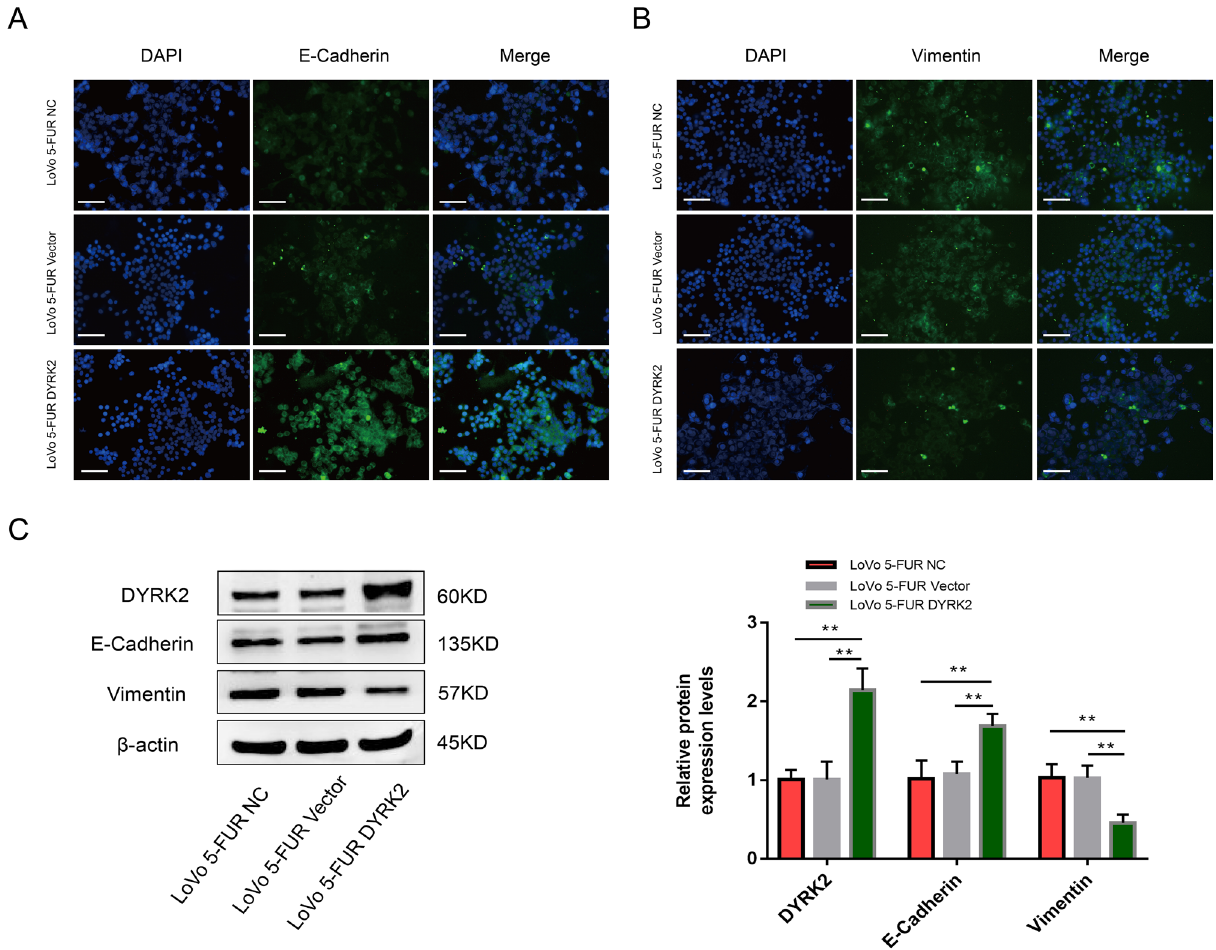
Figure 5. DYRK2 overexpression restores the epithelial phenotype of 5-FUR LoVo cells. ( A , B ) DAPI (blue) and secondary antibodies (green) were used for cellular staining. Scale bar: 50 μm (× 200). ( C ) DYRK2 and EMT marker proteins were detected via Western blotting. β-Actin served as a loading control. Data are means ± SD (n = 3). ** P <